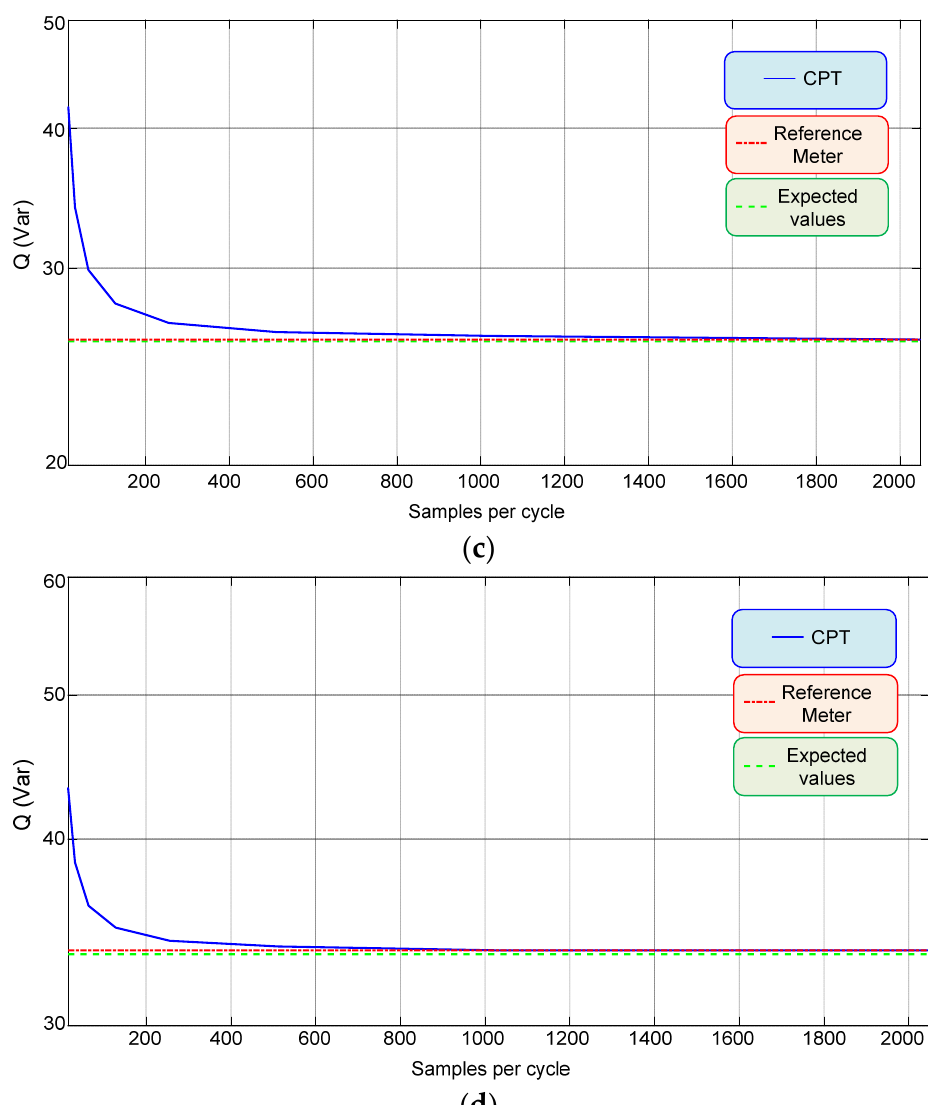
Figure 9. Non-linear load reactive power. ( a ) Firing angle of 0°, ( b ) Firing angle of 30°, ( c ) Firing angle of 60°, ( d ) Firing angle of 90°.